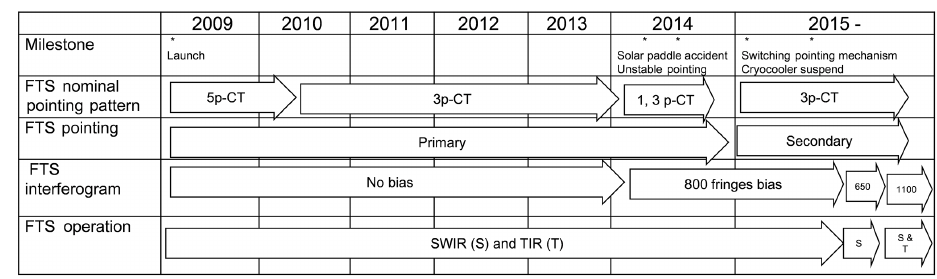
Figure 1. Long-term operation status. Note: there is no change in the operation of TANSO-CAI and